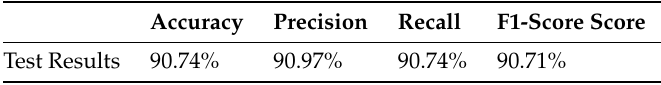
Table 14. Evaluation results of the model trained by LSTM